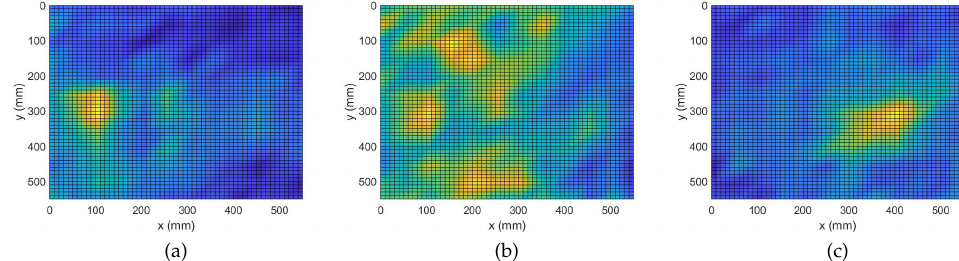
Figure 3. Damage Detection with Complex Group Lasso. ( a ) M 1 : 1 point-like mass. ( b ) M 4 : 4 point- like masses. ( c ) M E : 1 extended mass.